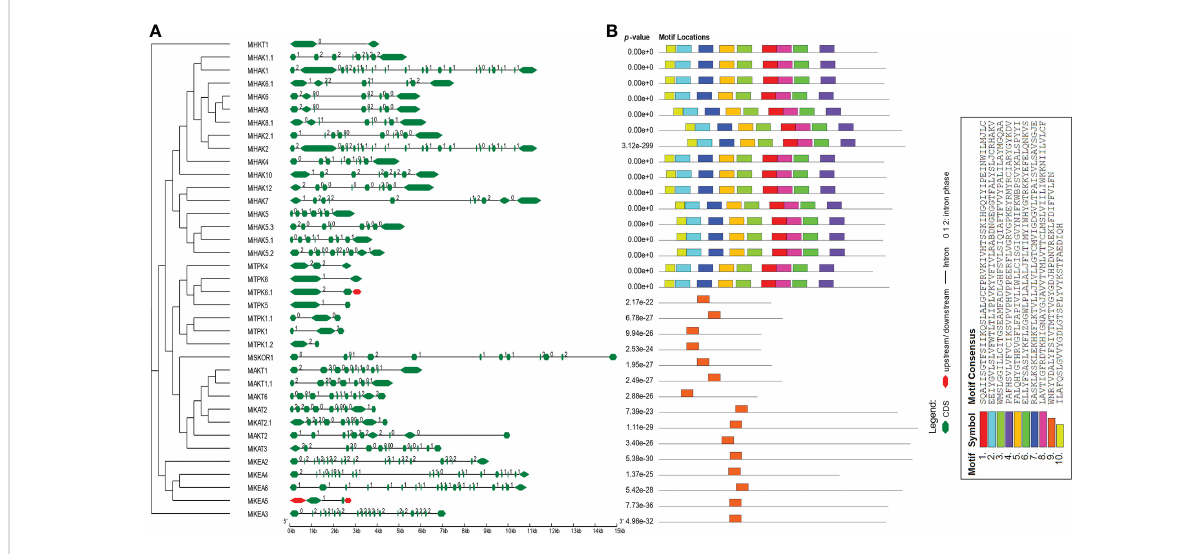
FIGURE 2 Genomic and proteomic features of PTGs. (A) Intron/exon architecture of PTGs in Mangifera indica . The green lines indicate introns. The upstream and downstream regions of genes are represented in red color. The exons are represented by green shapes. (B) Prediction of conserved motifs PTG proteins from M. indica . The conserved motifs are shown in this fi gure along with their motif details.